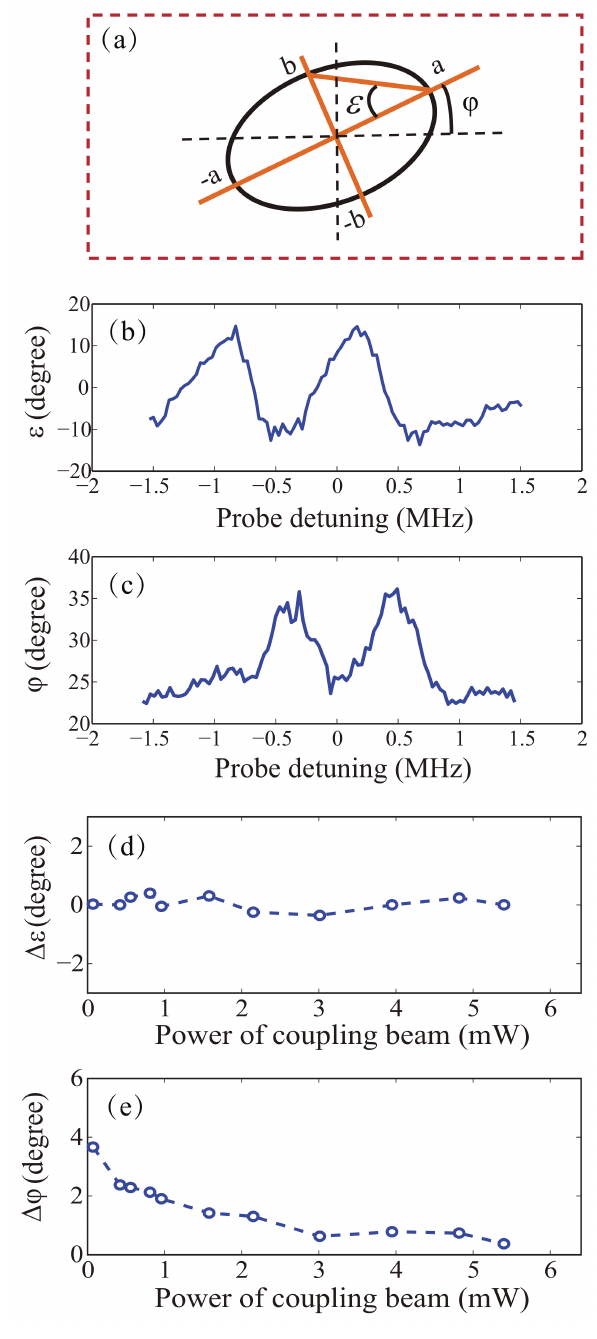
Figure 11. ( a ) Schematic definition of the ellipticity, ε , and the orientation angle, ϕ , of an elliptically polarized light in the crystalline Oxy coordinate system. ( b ) The measured EIT-induced frequency-detuning spectrum of the ellipticity, ε , and ( c ) the measured EIT-induced frequency-detuning spectrum of the orientation angle, ϕ , respectively, around the two-photon resonant condition. ( d ) The dependence of the EIT-induced ellipticity change, ∆ ε = ε − ε 0 , and ( e ) the dependence of the EIT-induced orientation angle change, ∆ ϕ = ϕ − ϕ 0 , respectively, on the coupling intensity at the exact two-photon resonant point. The dashed curves are guided for the eyes. Here, the polarization state of the probe light and the coupling light are initially the same and are set to be ( ϕ 0 , ε 0 ) = (20, 0). The coupling light is 3.7 mW for ( b , c ), and the probe light is 150 µ W for ( b – e ), respectively. Reprinted with permission from Springer: Applied Physics B [111], Copyright